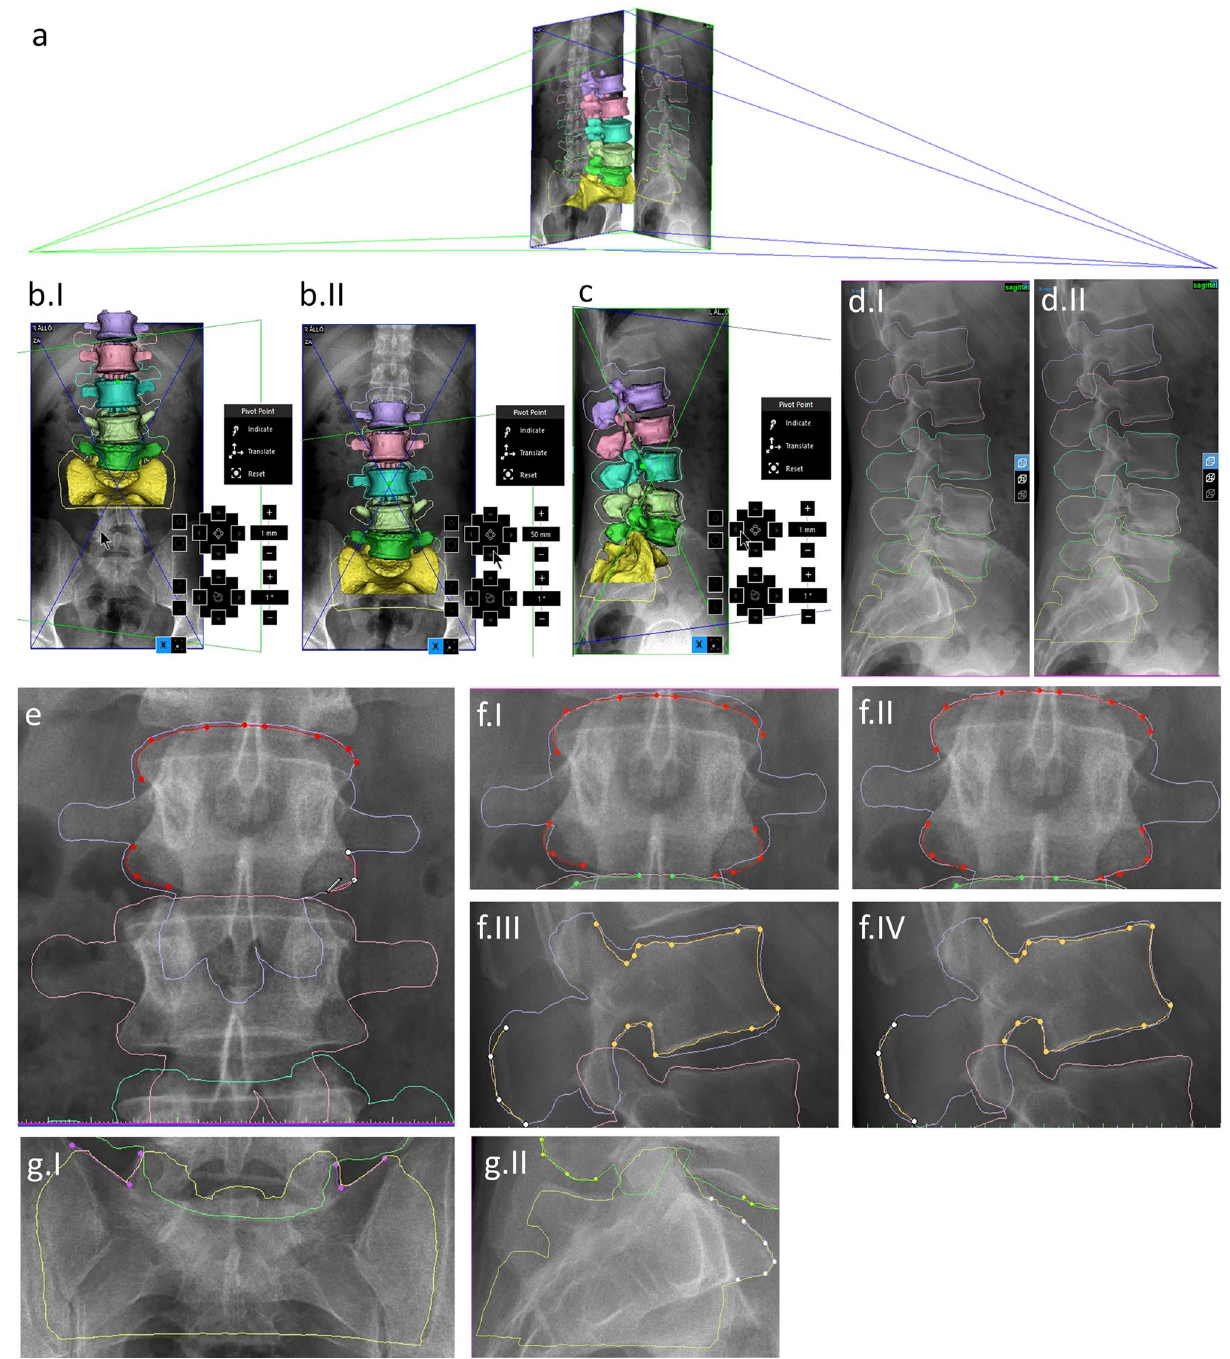
Figure 3. Registration of 3D lumbar spine geometry to standing radiographs. (a) simulated 3D environment with 3D lumbar spine geometry, radiographs, and radiation sources. ( b .I, II) manual registration of X-rays, before and after. ( c ) manual registration of vertebrae, 3D viewfinder with manual registration toolbar present. ( d. I, II) manual registration of vertebrae, before and after (e) contour selection, using the contouring tool. ( f ) automatic contour-based registration of a vertebra in the ( f .I, II) frontal and ( f .III, IV) sagittal planes before and after. ( g ) contours used for the registration of the sacrum. (Mimics® 21.0,